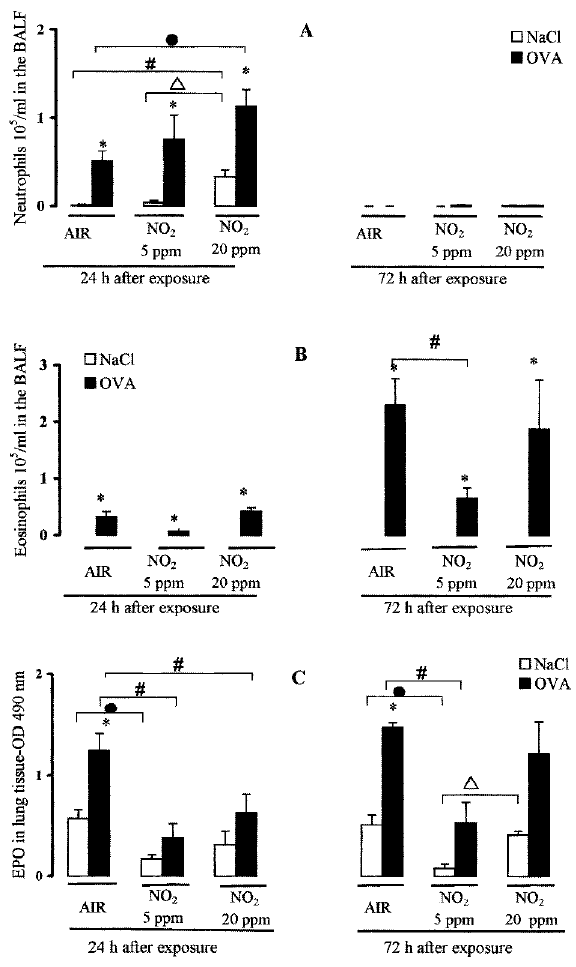
FIG. 3. BALF cell infiltration after exposures to NO 2 . At day 14, immunized mice were treated as in Fig. 2 (saline ( h ) or OVA ( j )). Differential BALF cell counts and EPO of the lungs were evaluated. (A) Neutrophils, (B) eosinophils and (C) eosinophil peroxidase. Data are expressed as the mean ± SEM. * p £ 0.05, OVA-challenged mice compared with their saline control; # p £ 0.05, OVA-air group compared with the NO 2 -OVA group (5 or 20ppm); d p £ 0.05, saline-air group compared with the NO 2 -saline group (5 or 20ppm); m p £ 0.05, 5ppm NO 2 -saline group compared with the 20ppm NO 2 - saline